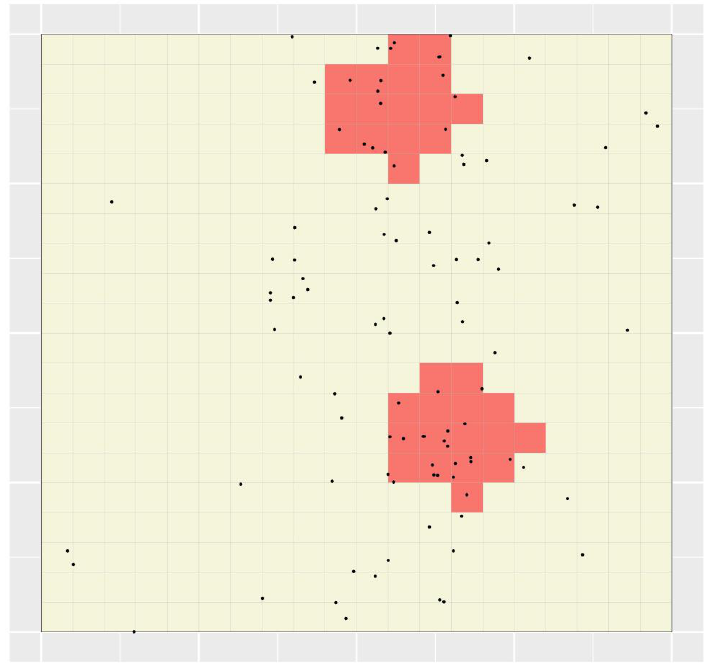
Figure 9. TRs delineated through applying a variation of the distance-weighted STA to a simulated dataset. Here, a requirement to delineate two, possibly contiguous TRs of a certain size has